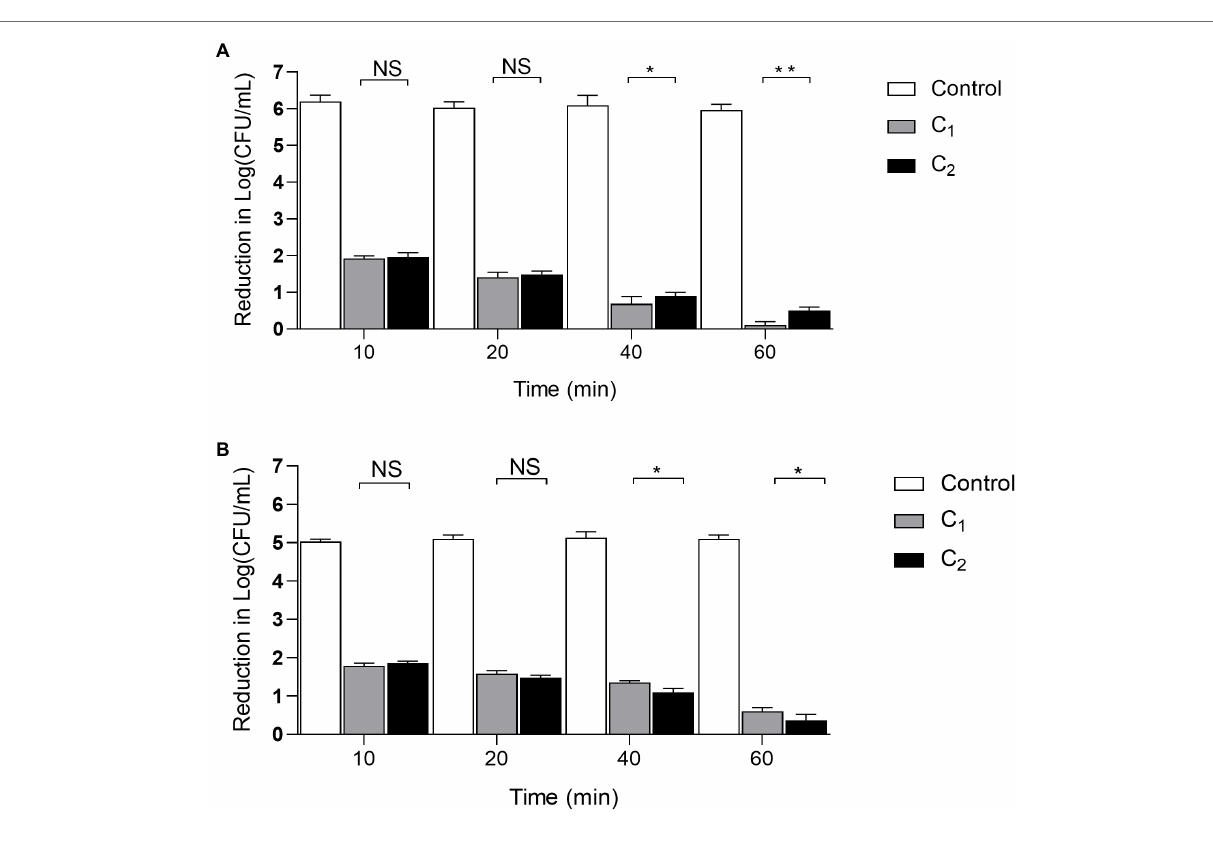
FIGURE 3 | The disinfection effect of Compound disinfectant. Clinical trials were divided into disinfection group (C 1 , C 2 ) and control group. Four different action times were selected to determine the best action time and the clinical bactericidal effect of the disinfectant according to the logarithmic value of the microbial reduction between each group. (A) : Air disinfection; (B) : Ground disinfection; *** p < 0.001; ** p < 0.01; * p < 0.05, NS: Insignificant difference, n = 3. Data were presented as mean ± SD; C 1 , Compound disinfectant 1; and C 2 , Compound disinfectant